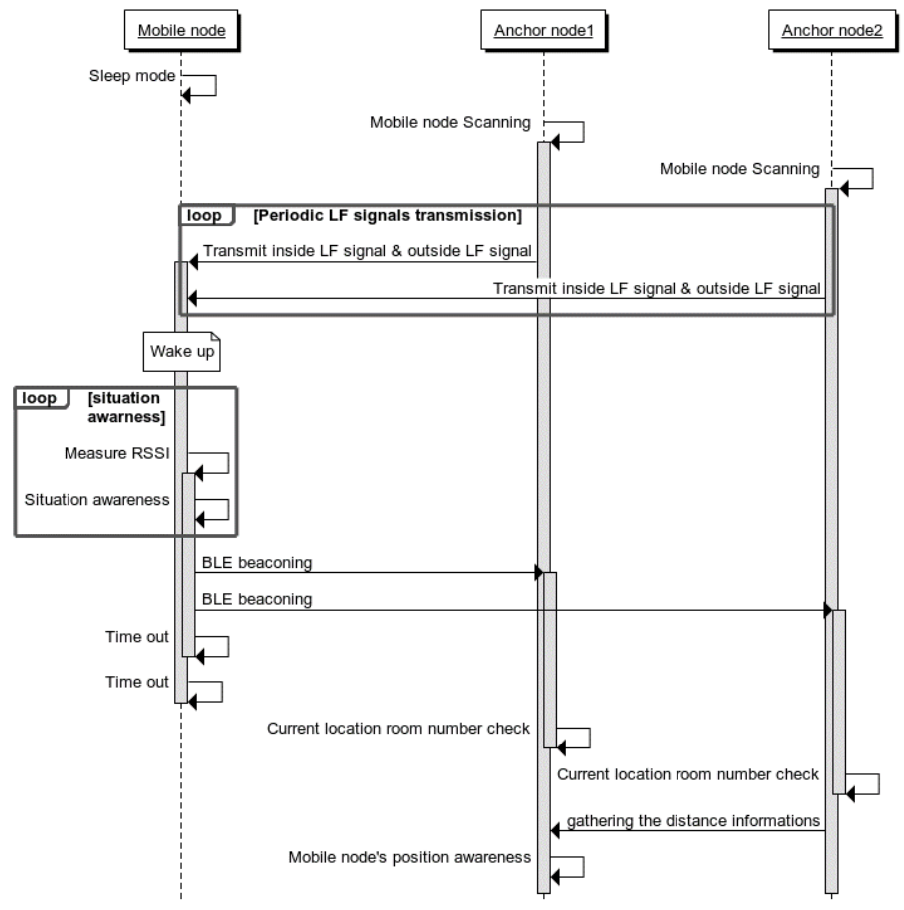
Figure 6. Situation-aware indoor localization system service sequence diagram.